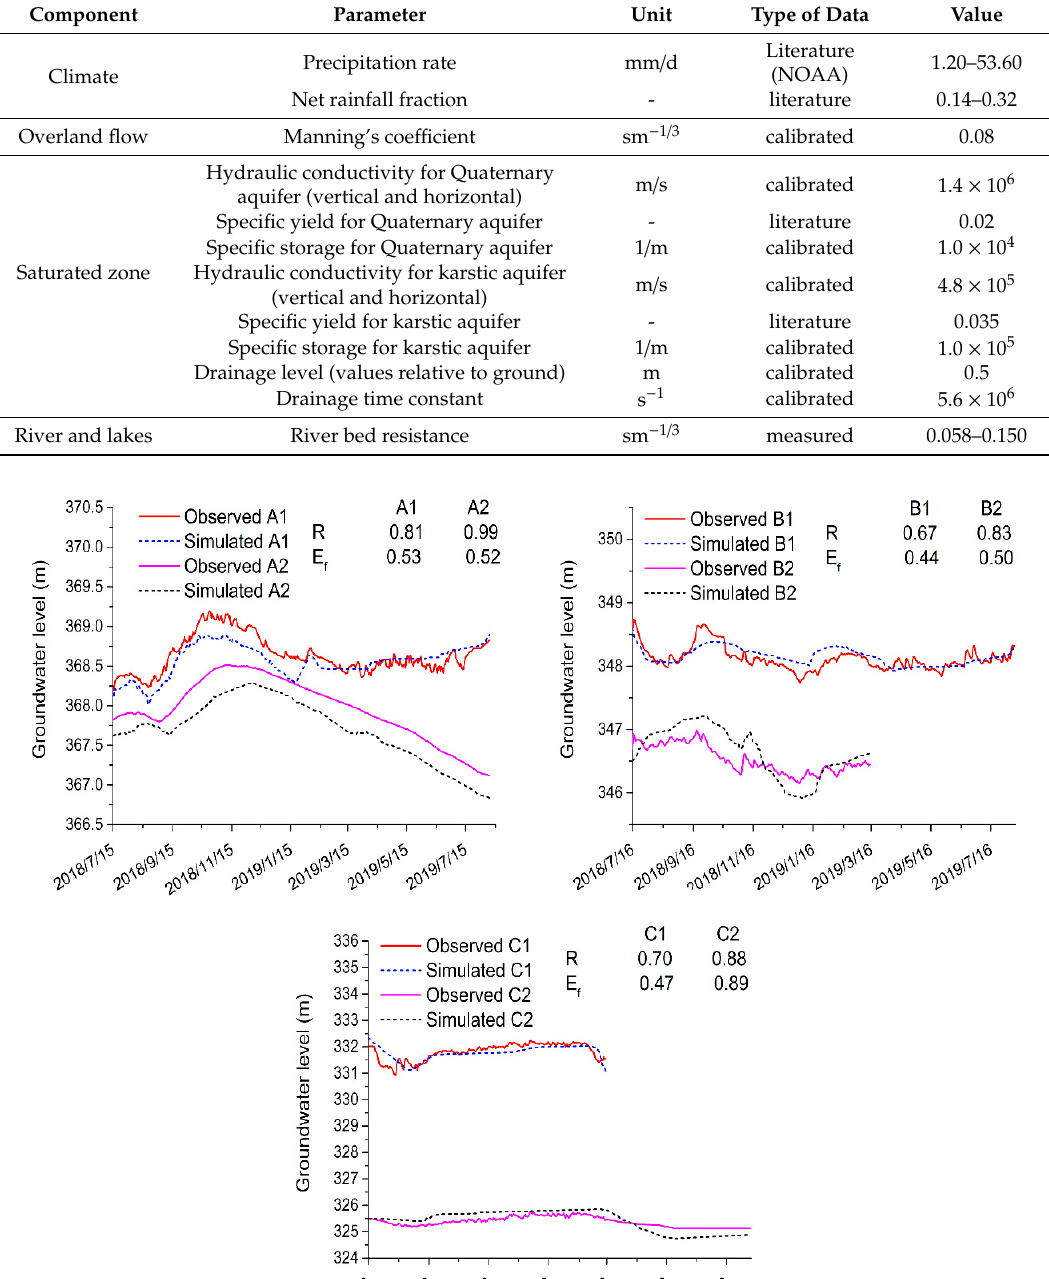
Table 2. Parameters obtained for the best fit simulation and ranges for the sensitivity analysis. Type of parameters are separated into the measured / literature value and calibrated values.